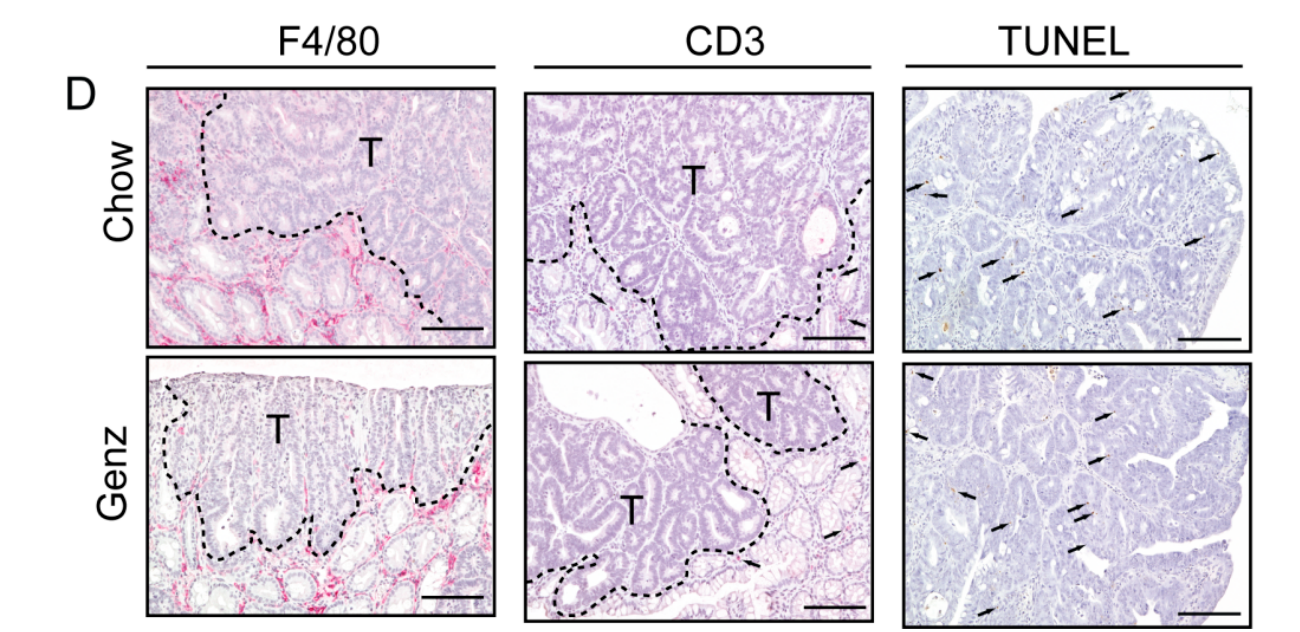
Figure 8. The number of colorectal adenomas were reduced in Genz-treated mice. ( A ) Ki67 staining indicated proliferative cells in colons of mice. Both Genz-treated mice and controls developed predominantly adenomas with its typical polypoid-like shape ( A , B , middle images) and only low numbers of adenocarcinomas ( A , B, lower images). However, Genz-feeding markedly reduced the number of adenomas as compared to chow-fed controls ( B ). ( C ) The number of Ki67 positive cells in the colorectal parts of the colons was lower in crypts of Genz-treated mice as compared to controls; each data point represents mean numbers of Ki67 positive cells of approximately 50 crypts per mouse. Counted were positive cells only from completely vertically cut villi apart from the tumor areas; significances are *, p ≤ 0.05; ***, p < 0.001. ( D , F4/80) Both Genz-fed mice and controls lacked macrophage infiltrations in the tumor but showed an enrichment in peritumoral areas. ( D , CD3) Only a few cells stained positive with the T cell marker CD3; T, tumor area. Genz treatment did not lead to increased apoptosis ( D , TUNEL); a few cells with smaller nuclei than epithelial cells stained positive in tumors of treated mice and controls; scale bars, 100 µM.